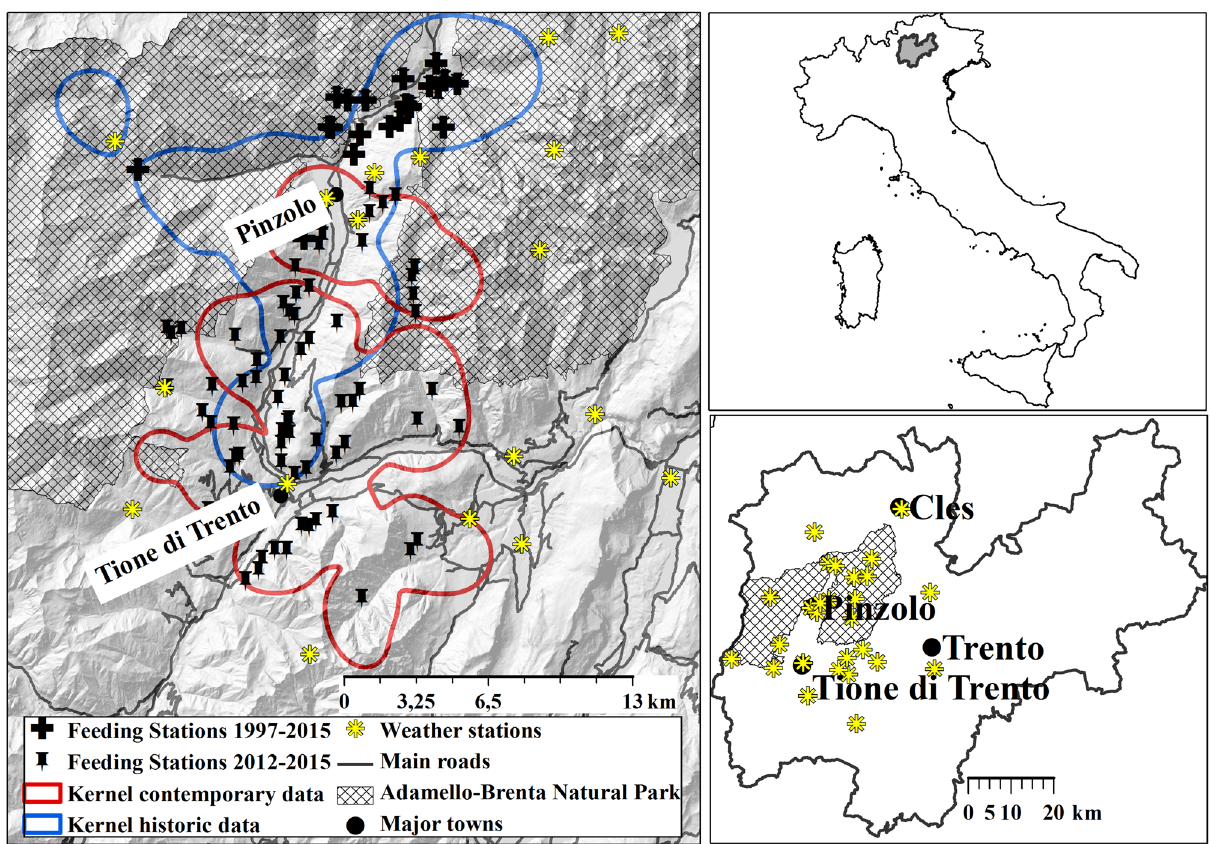
Figure 1. Study area in the Italian Alps, with insets of Italy (top right) and Trentino Province (bottom right). Polygons are shown for the overlapping historical (blue) and contemporary (red) roe deer population (kernel densities 99% based on radio-telemetry relocations). Supplemental feeding sites are indicated for each period as well as the 23 weather stations used to run GEOtop simulations (Supplementary